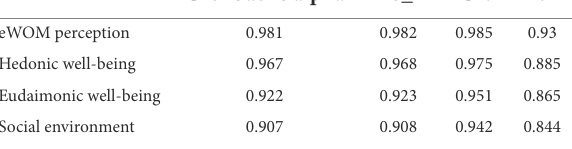
TABLE 6 Study 2: The facet reliability and validity of each variable (social